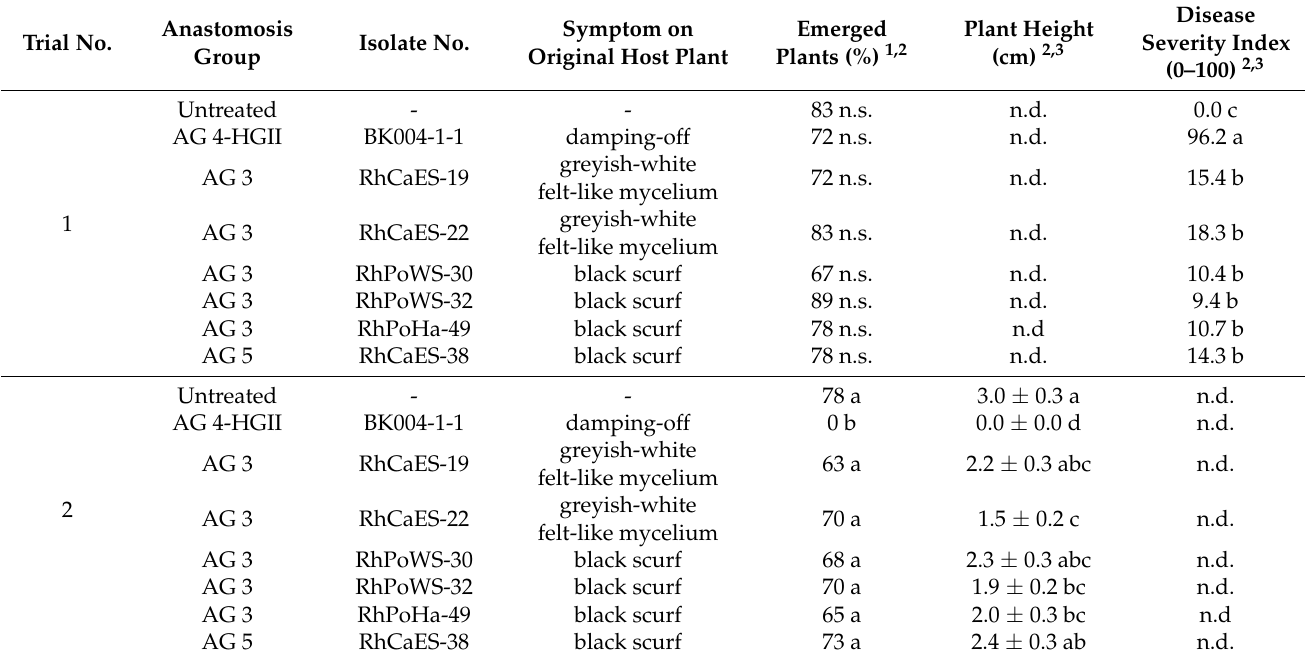
Table 4. Pathogenicity towards carrot seedlings (cv. Nantes) of six R. solani isolates belonging to AG 3 and AG 5, isolated from carrot and potato. Isolate BK004-1-1 (AG 4-HGII) was used as a positive control, inducing damping-off [17].